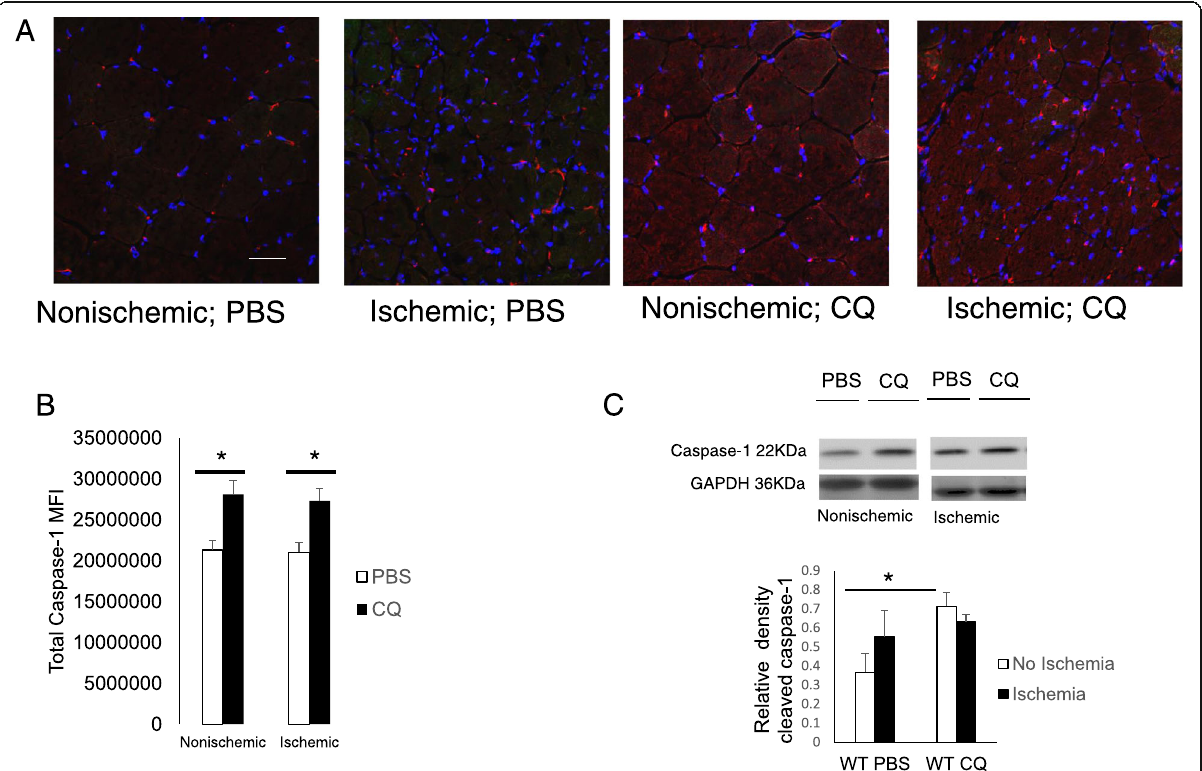
Fig. 3 CQ increases caspase-1 expression in muscle. a Immunofluorescence of tibialis anterior (TA) muscle harvested 21 days after unilateral femoral artery ligation (FAL) in WT (C57Bl6/J) mice treated with PBS or CQ (50 mg/kg). Caspase-1 (red); DAPI nuclear stain (blue). Representative images shown ( b ) Caspase-1 mean fluorescence intensity (MFI) calculated after color separation using Image J analysis. * P < 0.01, PBS:CQ in WT and KO. c Western blots of cleaved caspase-1 and GAPDH loading control in whole muscle homogenates. Semi-quantitative analysis performed with Image J Gel Analysis of expression of cleaved caspase-1 relative to GAPDH. * p < 0.001 PBS:CQ, N = 4 – 5 mice per experimental group; Scale bar = 10 μ